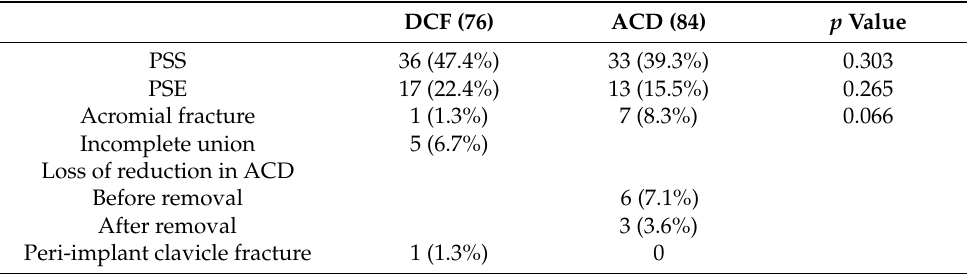
Table 2. Frequency of complications using hook plate in the distal clavicle fracture and acromioclav- icular joint dislocation